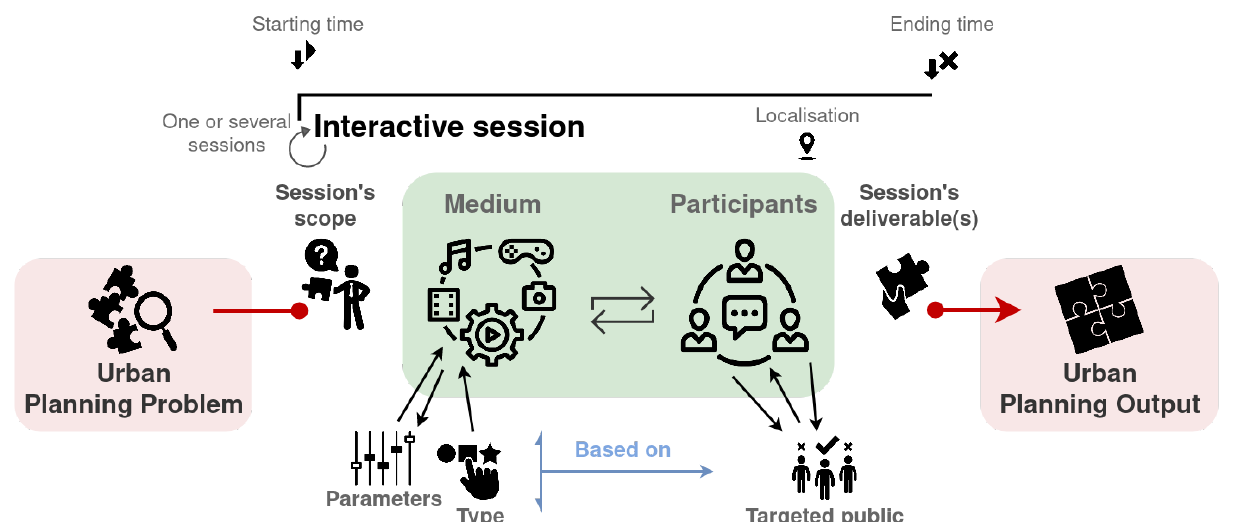
Figure 1. Schema of urban public participatory approaches initiated by